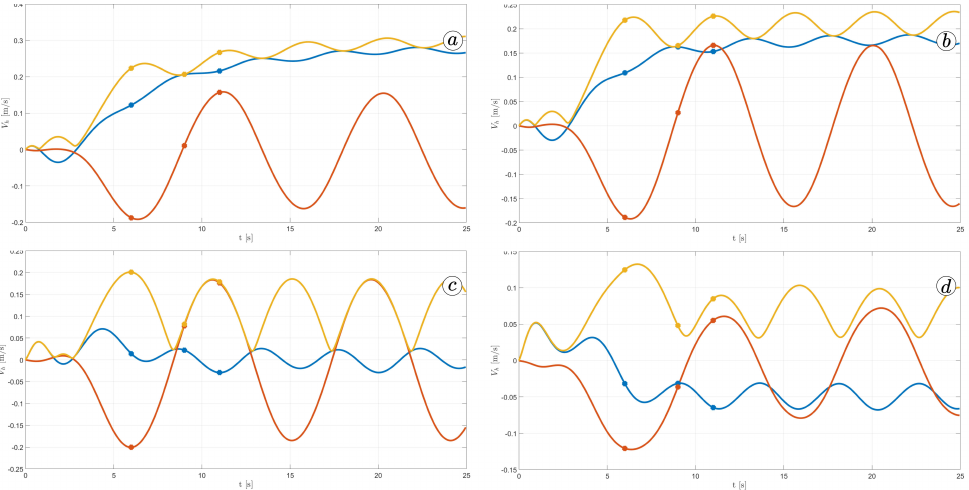
Figure 12. Velocity of the snake robot’s head for c t = 0.1 and c n = 10 ( a ) c t = 1 and c n = 10 ( b ), c t = 10 and c n = 10 ( c ), and c t = 10 and c n = 1 ( d